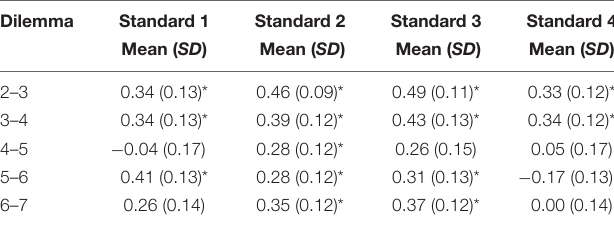
TABLE 7 | Bootstrapped correlations over two dilemmas using model parameters estimated from dilemma 2 and 3 – final